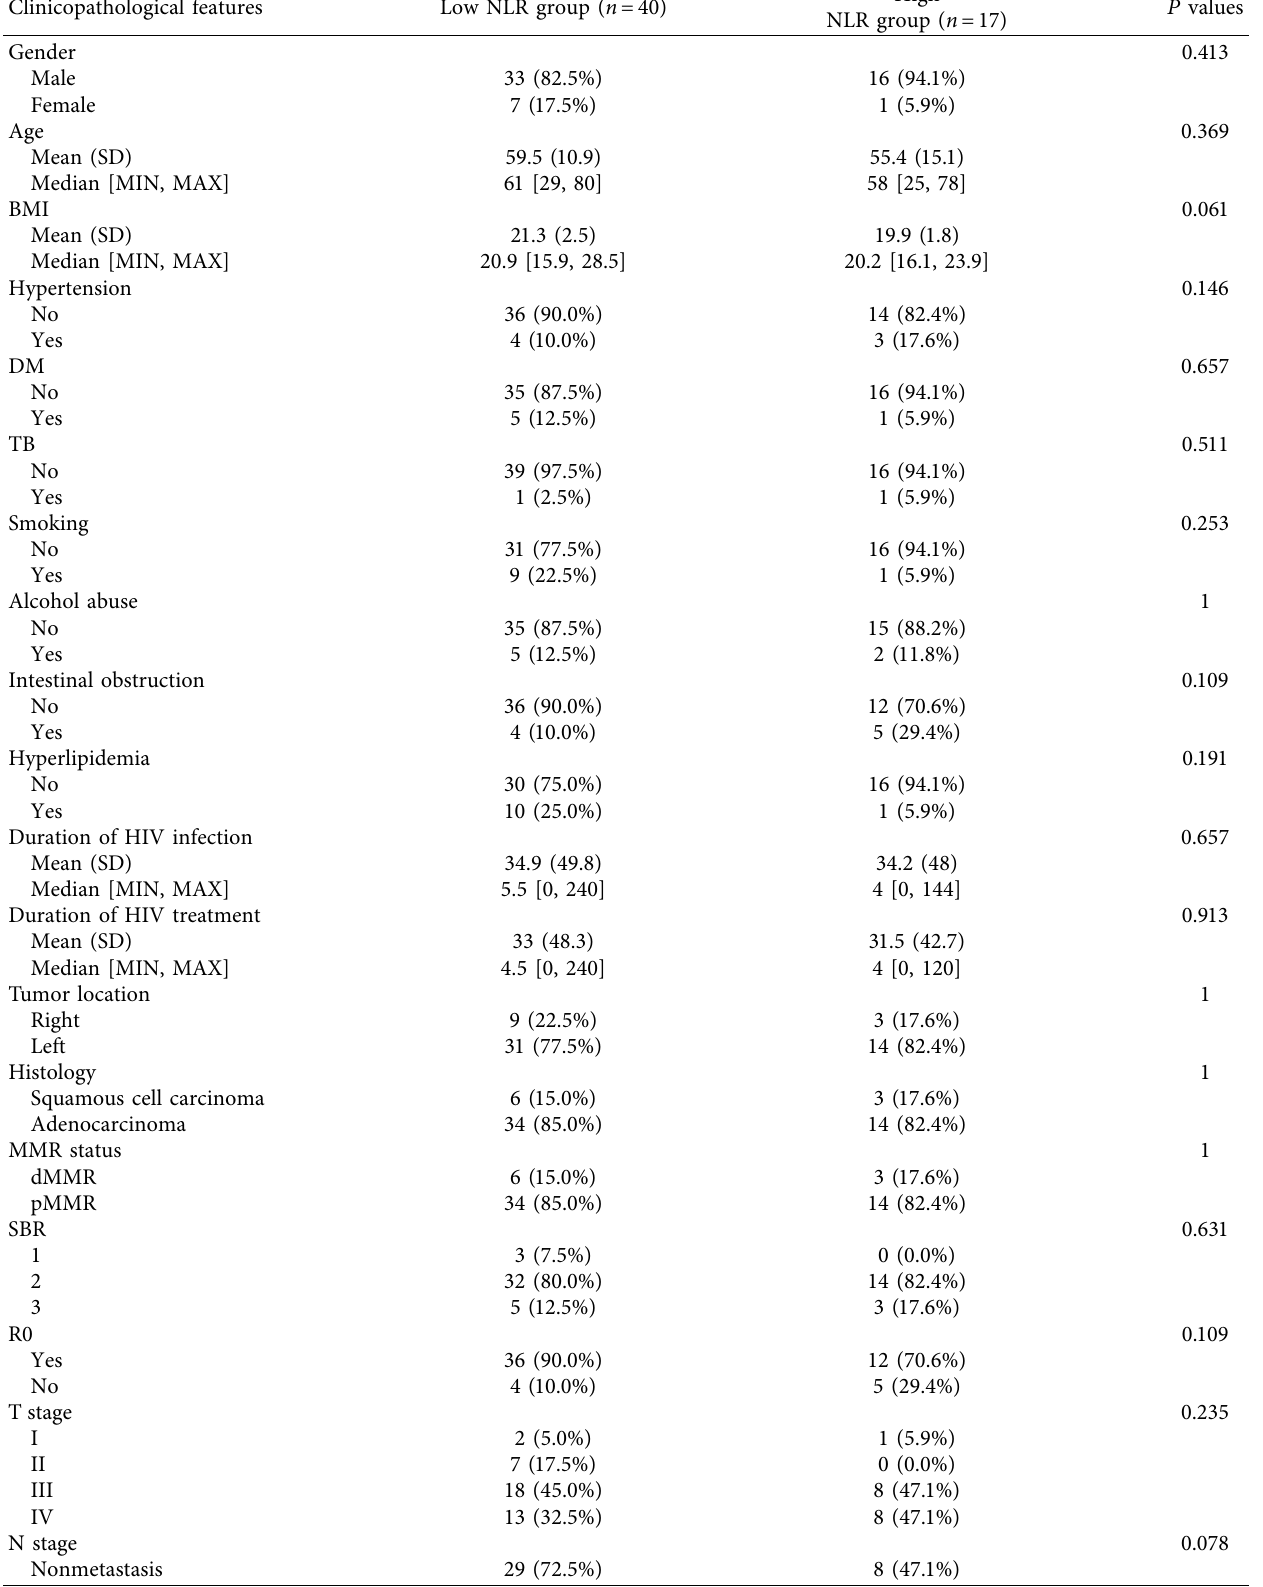
Table 1: Relationship between NLR subgroups and clinicopathological features in CRC patients living with